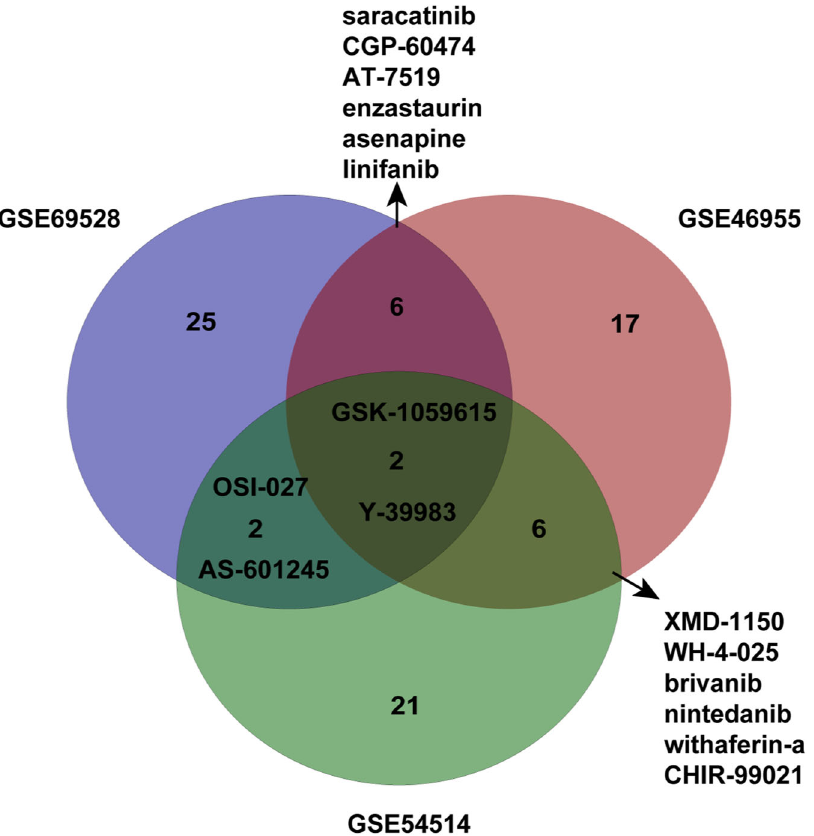
Fig. 3 Overlap of three candidate drug lists. Venn diagram showing candidate drugs for sepsis obtained from the three datasets. Sixteen drugs appeared in at least two